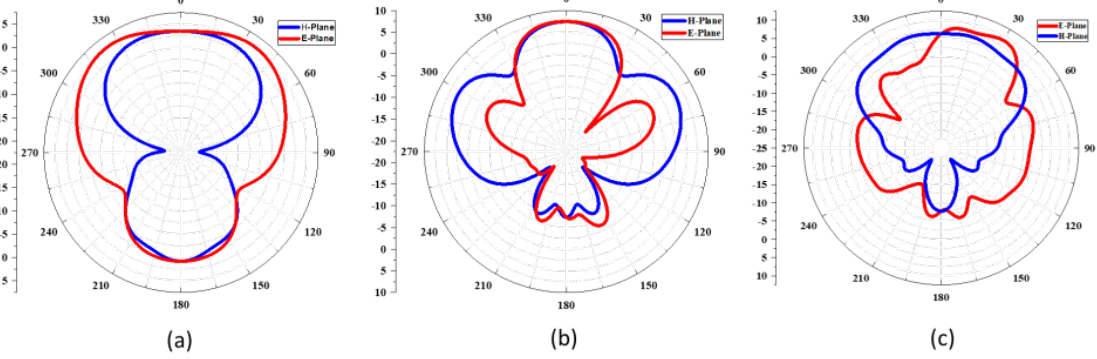
Figure 11. Antenna’s 2D radiation pattern over phantoms at the following frequencies: ( a ) 28 GHz, ( b ) 38 GHz, and ( c ) 60 GHz.